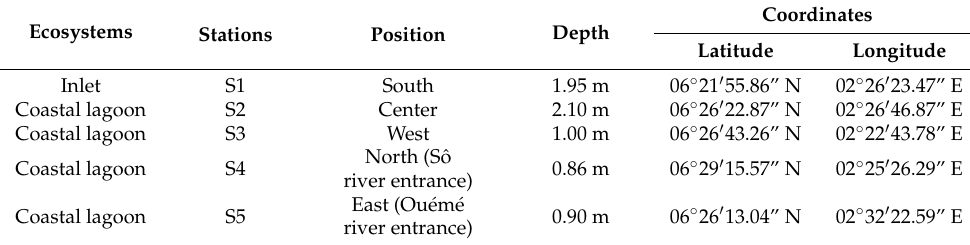
Table 1. Characteristics of the sampled